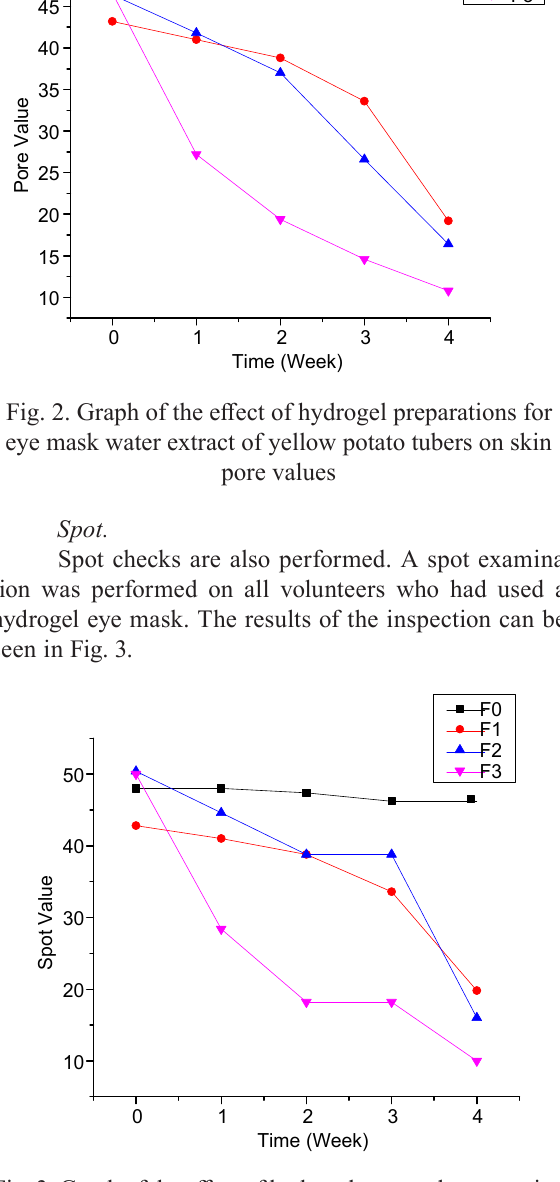
Fig. 3. Graph of the effect of hydrogel eye mask preparation of yellow potato tuber water extract on spot